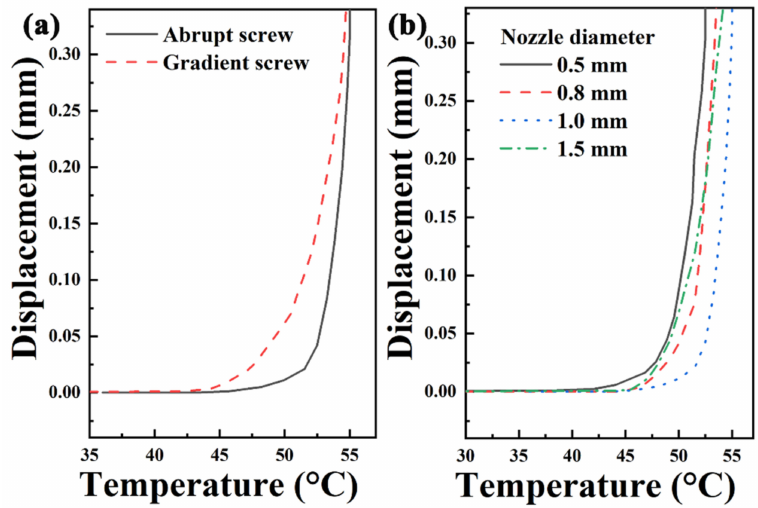
Figure 6. HDT curves of samples printed by ( a ) two kinds of screws and ( b ) various nozzle diameters.